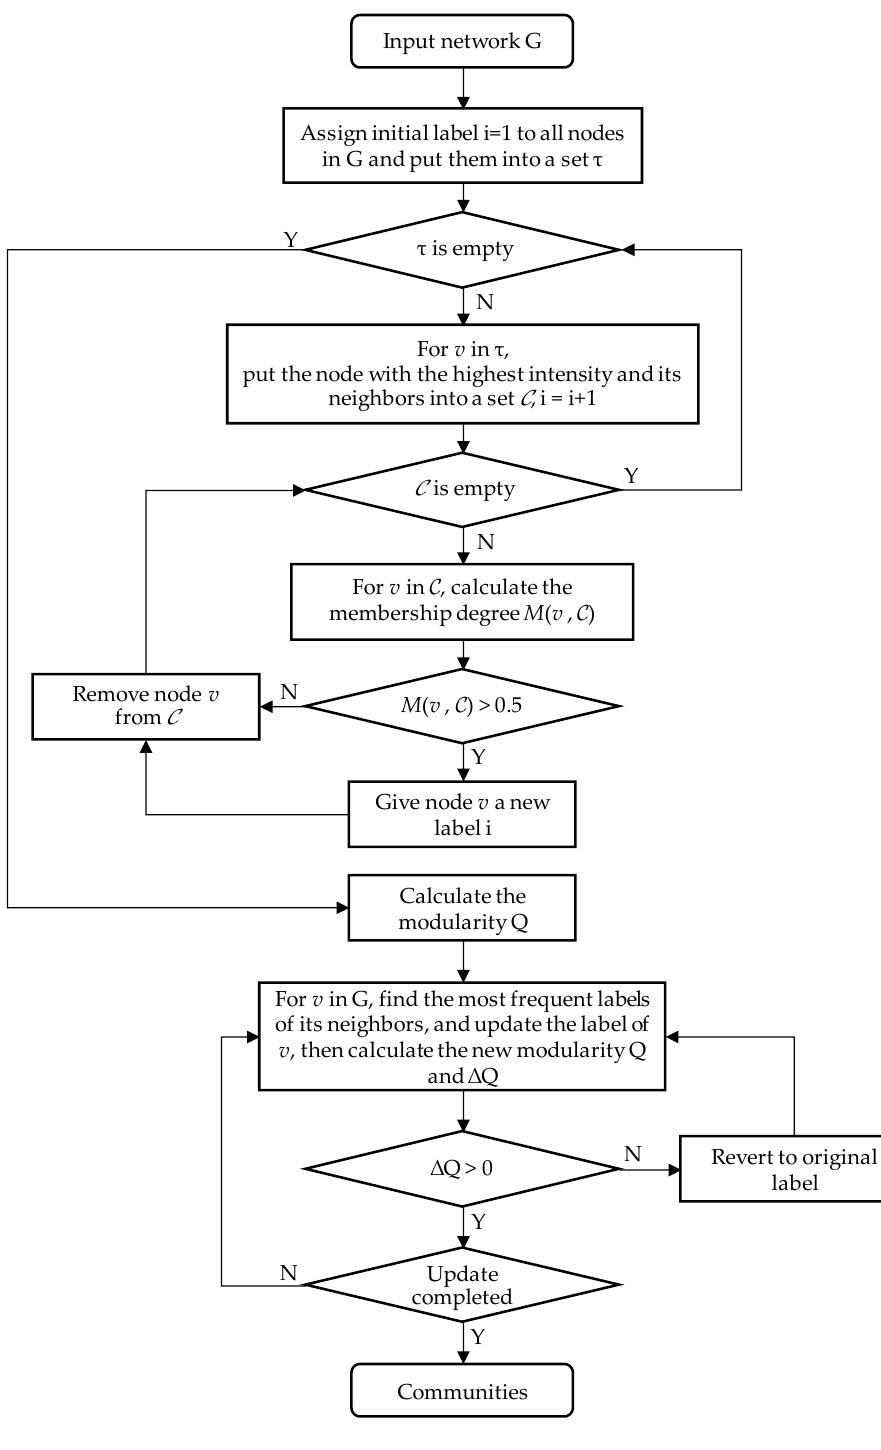
Figure 2. The flow chart of MILPA.